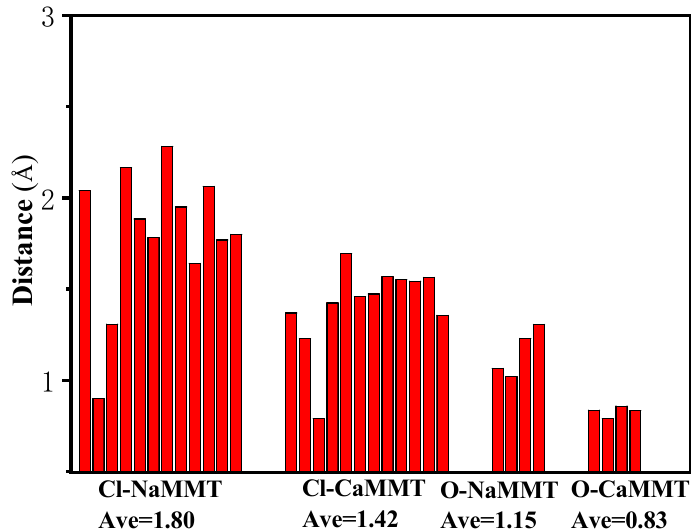
Figure 3. The distance between the chlorine atom and P=O to the surface of MMT.